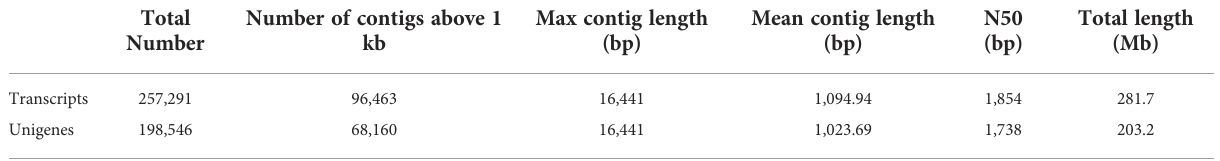
TABLE 2 Summary statistics of the assembled fi nger millet transcripts and unigenes: total number, number of contigs above 1 kb, maximum contig length, mean contig length, N50, and total